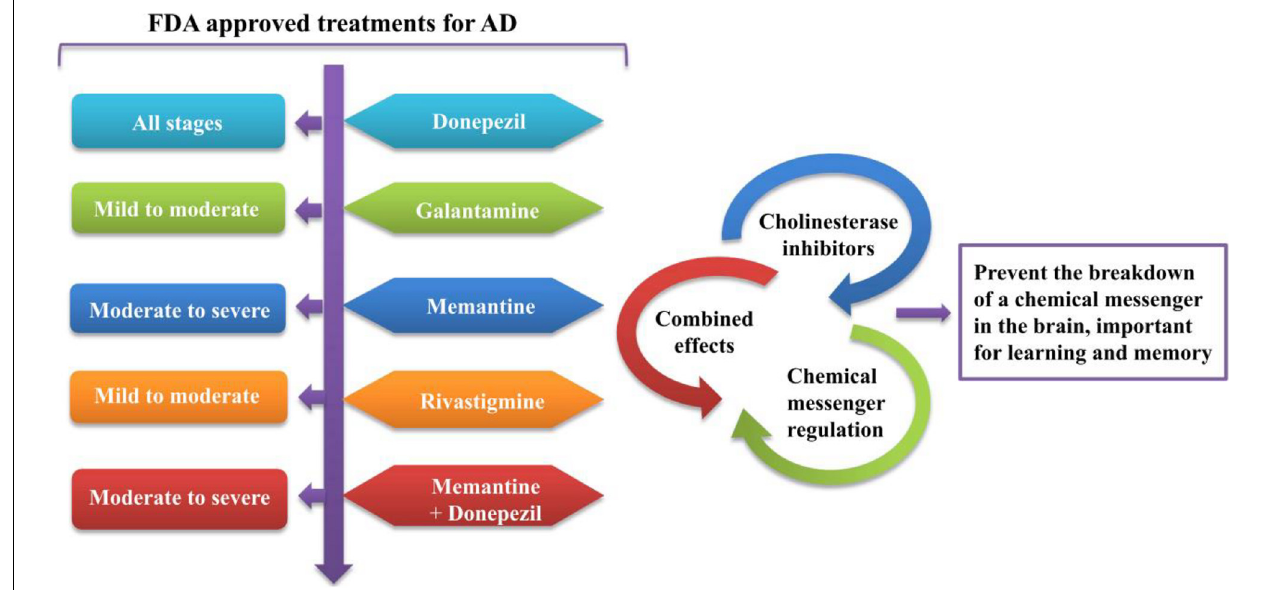
FIGURE 3 | The functioning of currently FDA-approved drugs to treat the symptoms of AD. FDA, Food and Drug Administration; AD, Alzheimer’s